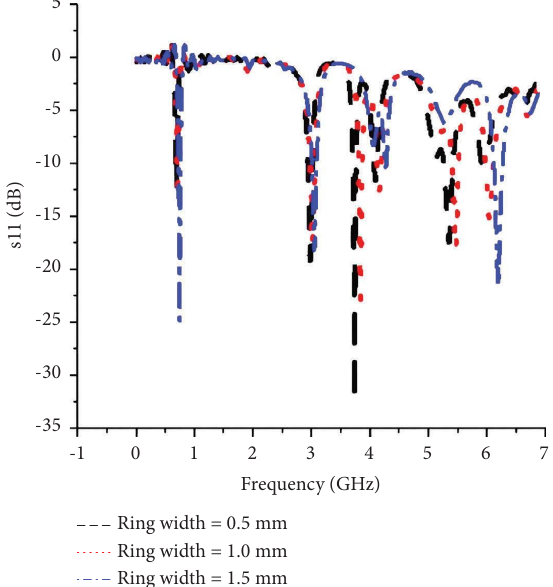
Figure 7: S 11 comparison plot for various number of